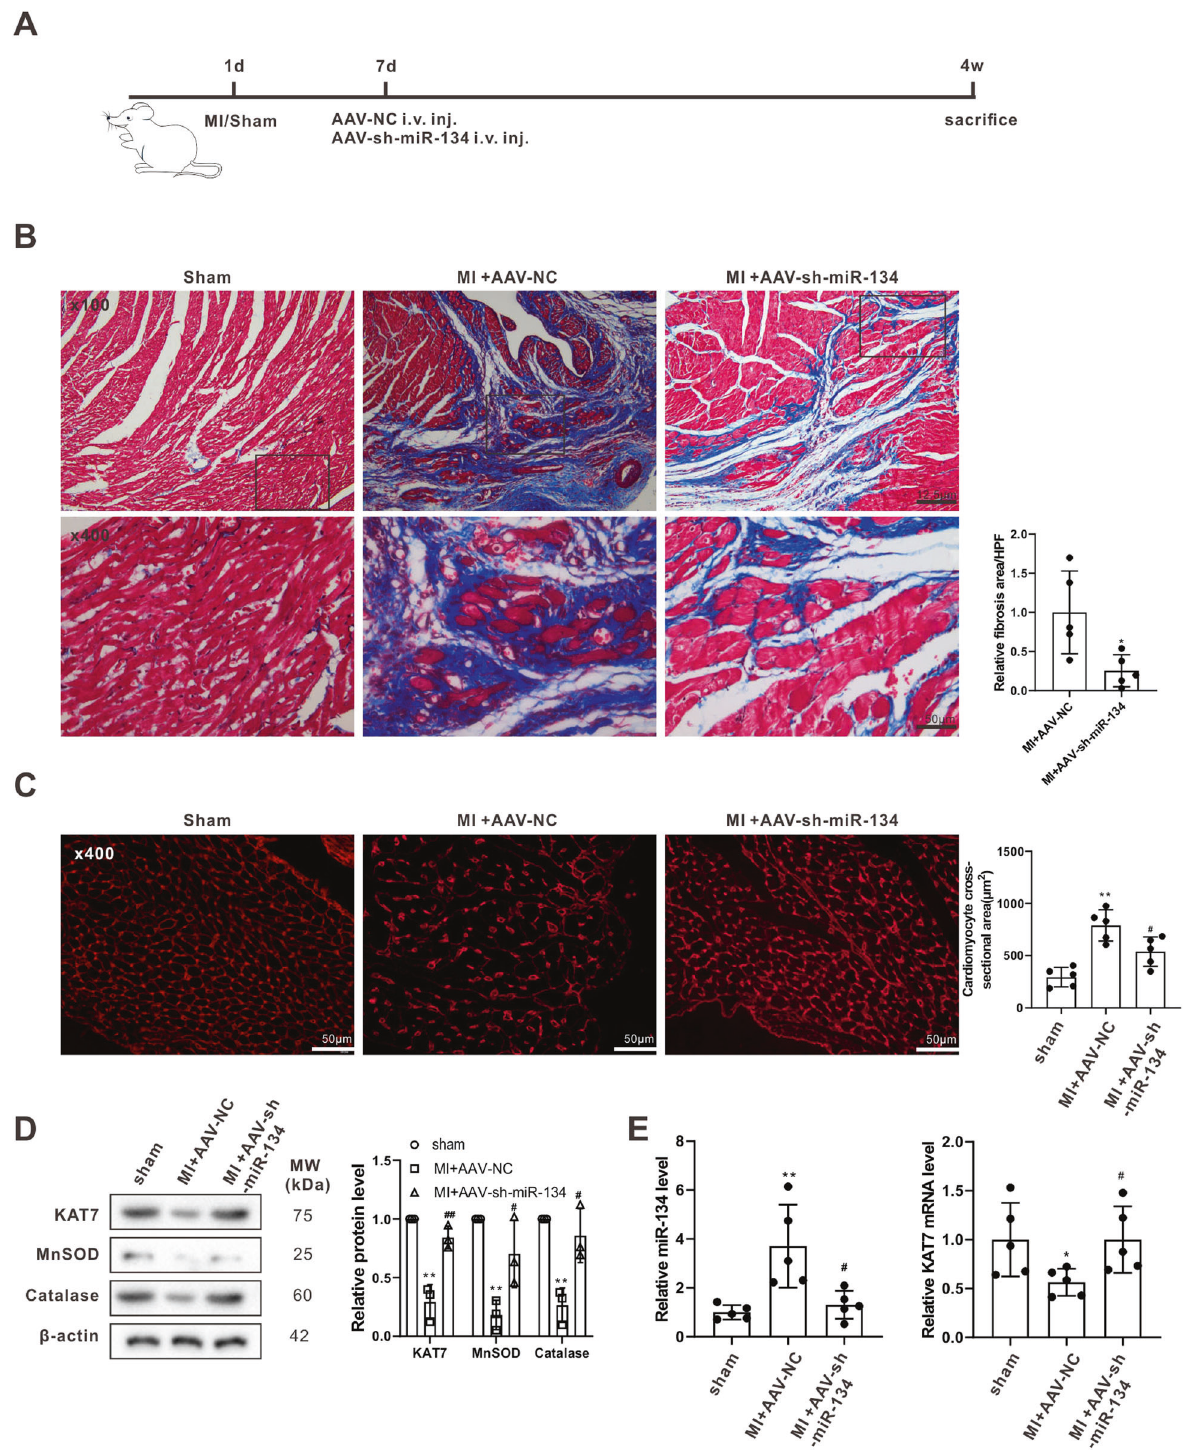
Fig. 6 miR-134 knockdown alleviated adverse myocardial remodeling in the rat model of MI. A The experimental protocols of sham ( n = 10), MI + adeno-associated virus (AAV)-sh-miR-134-5p ( n = 10), and MI + the negative control of AAV-sh-miR-134-5p (AAV-NC) ( n = 10). B Myocardial fi brosis was examined using Masson ’ s trichrome staining. C Cardiomyocyte cross-sectional area was examined using WGA staining (scale bar = 50 µm). D The protein levels of KAT7, MnSOD, and catalase in the left ventricular tissues of rats in each group. E The miR- 134-5p level and KAT7 mRNA level in the left ventricular tissues of rats in each group. B * P < 0.05 vs MI + AAV-NC. C – E * P < 0.05, ** P < 0.01 vs sham; # P < 0.5 vs MI +